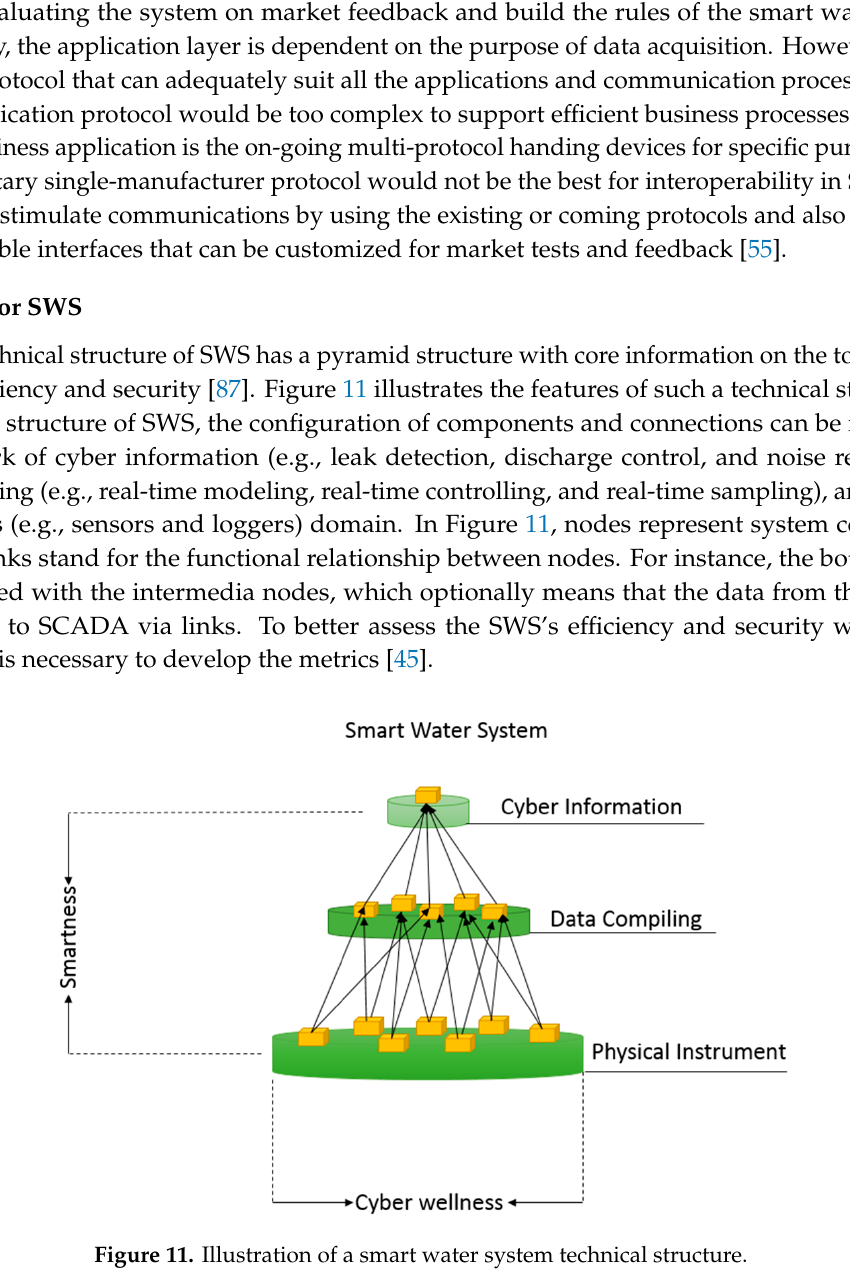
Figure 11. Illustration of a smart water system technical structure.